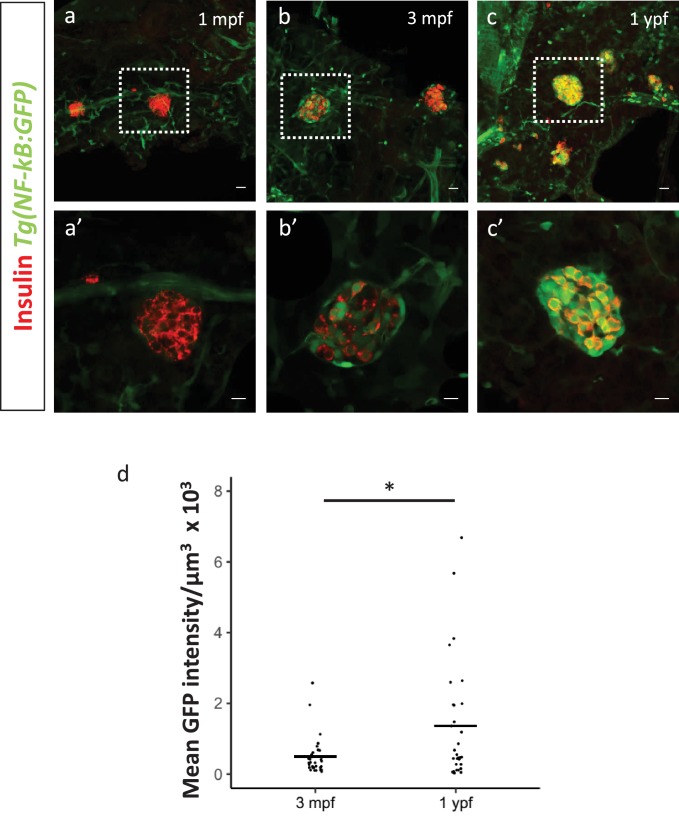
Activation of NF-kB signaling in beta-cells of the secondary islets with age.(a,b,c) Confocal stack of secondary islets from Tg(NF-kB:GFP) animals at 1 mpf, 3 mpf and 1 ypf. Beta-cells were labeled using an insulin antibody (red). NF-kB:GFP reporter expression is shown in green. Scale bars 20 µm. (a’,b’,c’) Insets show high-magnification single planes of the confocal stacks corresponding to the regions outlined using white dotted-lines in the top panels. Scale bar 10 µm. (d) Graph showing the total normalized GFP fluorescence intensity of the secondary islets from 3 mpf (n = 9 fish, secondary islets = 32) and 1 ypf (n = 8, secondary islets = 30) animals. Each dot represents one islet (two-tailed t-test, *p<0.05).